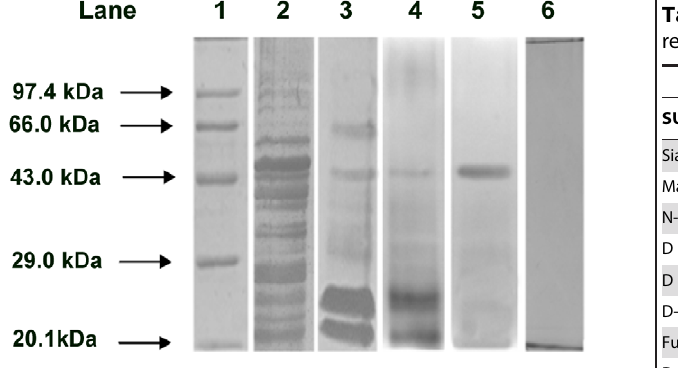
Figure 5. Electrophoretic analysis of AMFL. Lane 1. Marker; lane 2. SDS – PAGE of crude extract stained with silver nitrate; lane 3. SDS – PAGE of 60% ammonium sulphate precipitate of Aegle marmelos fruit extract stained with silver nitrate; lane 4. SDS – PAGE of peak II protein (AMFL) stained with silver nitrate showing , 25 kDa and , 21 kDa protein; lane 5. Non reducing SDS – PAGE of peak II protein (AMFL) stained with silver nitrate showing , 45 kDa protein; lane 6. Non reducing SDS – PAGE of peak II elution protein (AMFL) stained with PAS - silver nitrate showing negative for glycoprotein.